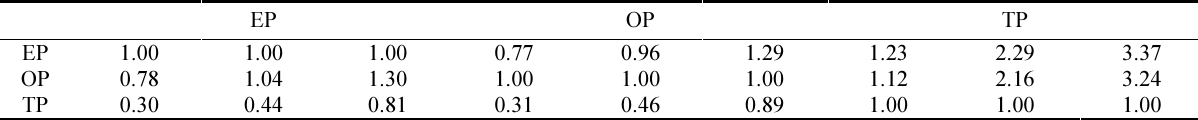
Table 4. Synthetic pairwise comparison